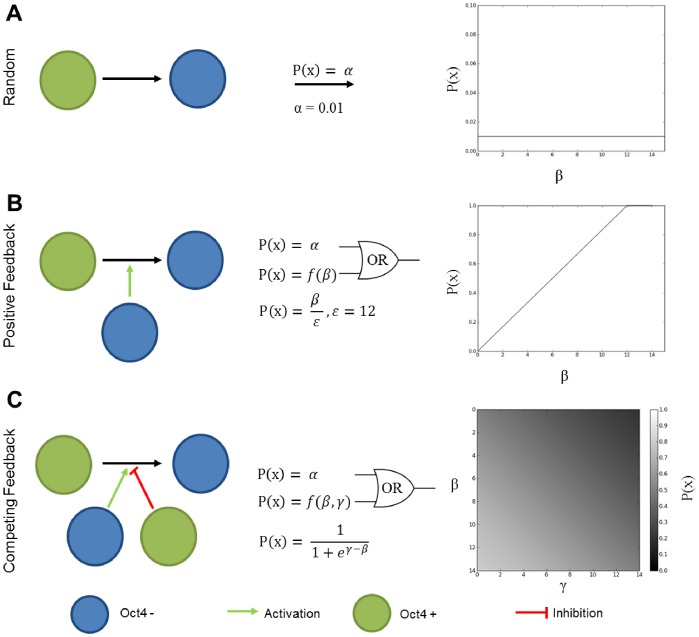
Overview of rule configurations.Three different rule configurations governing transition from the undifferentiated to differentiated state are shown: random (A), positive feedback (B), and competing feedback (C). The random rule is governed by a constant probability of differentiation denoted by α (A). The positive feedback rule takes into account Oct4− cells denoted by β, and allows them to positively influence the differentiation probability (B). The competing feedback rule take into account β and also the number of Oct4+ cells denoted by γ (C). In the case of the positive feedback and competing feedback rules, the probability are combined using an or-gate logical operator. Representation of the probaility density functions P(x) are shown for each rule.